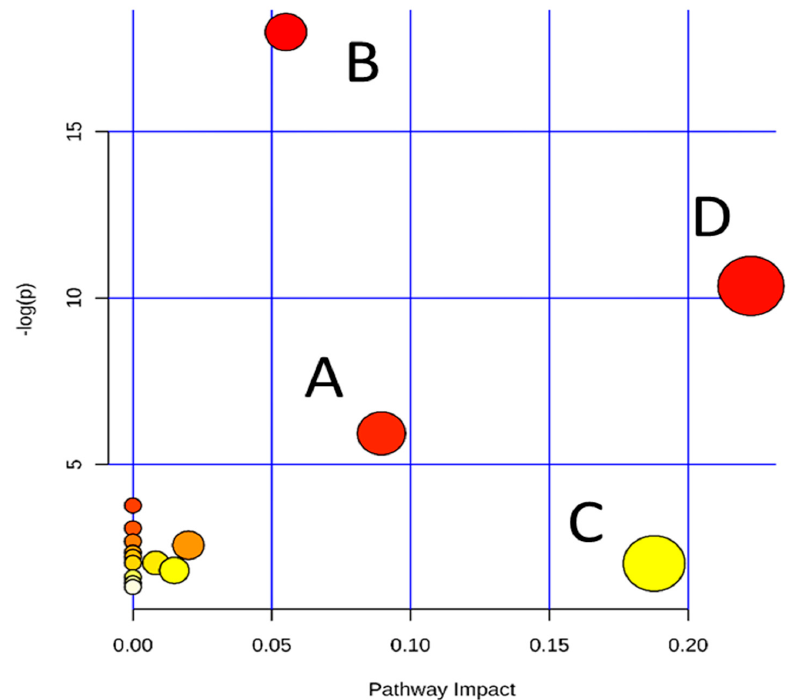
Figure 4. Overview of pathway analysis from pathway topology analysis. A: β -Alanine metabolism; B: glutathione metabolism; C: glycine, serine and threonine metabolism; and D: arginine and proline metabolism.